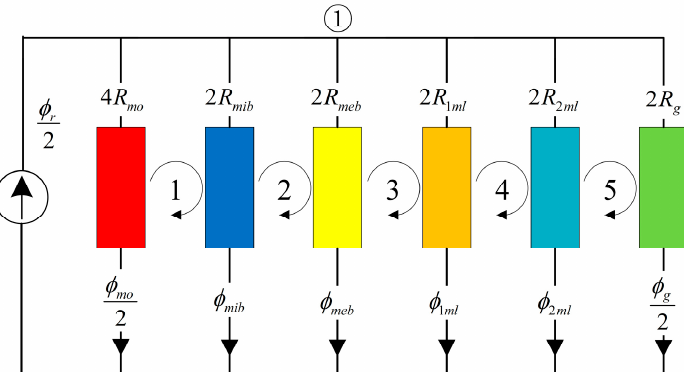
Figure 2. The simplified equivalent model based on LMC method.